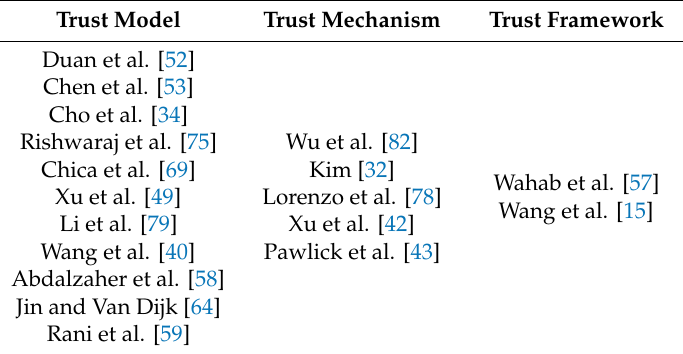
Table 2. Classification of trust